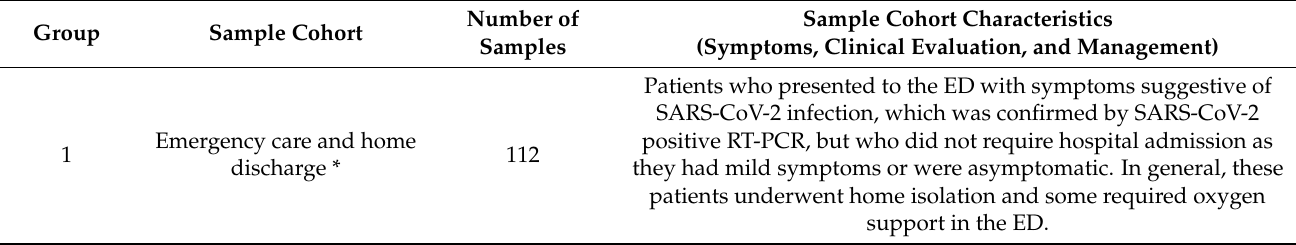
Table 1. Summary of sample